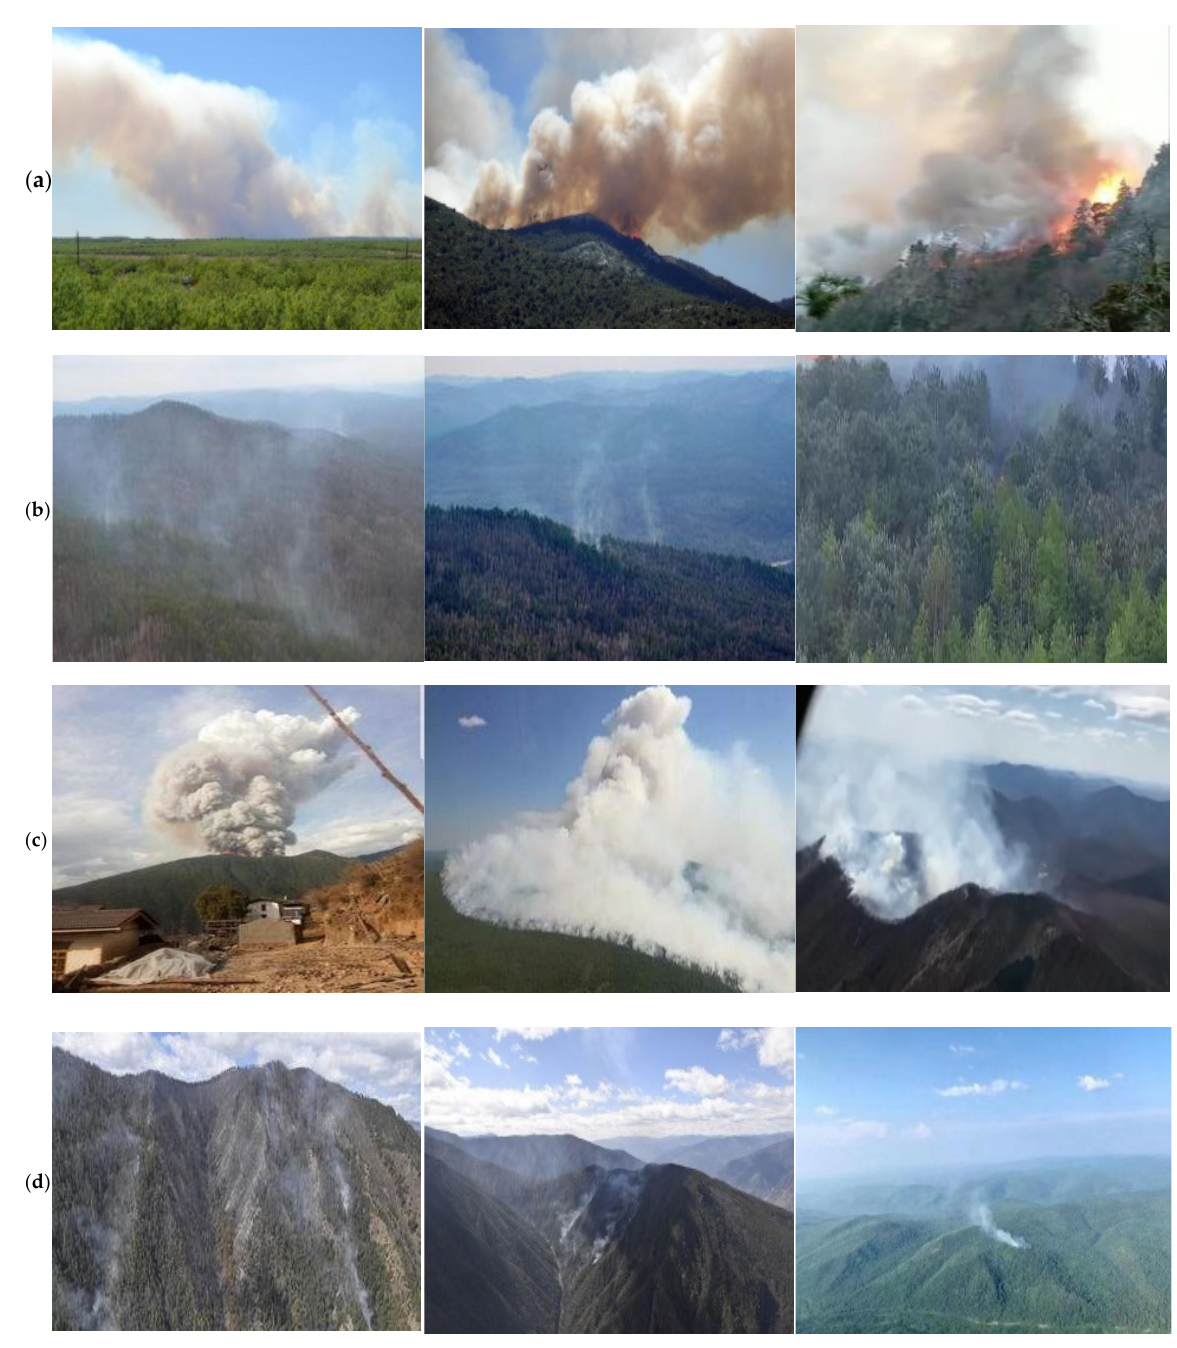
Figure 3. The four categories of the forest fire smoke dataset. ( a ) Thick smoke. ( b ) Thin smoke. ( c ) Thick smoke and clouds. ( d ) Thin smoke and clouds. Table 1. The distribution of the four categories for the forest fire smoke dataset. Thick Smoke